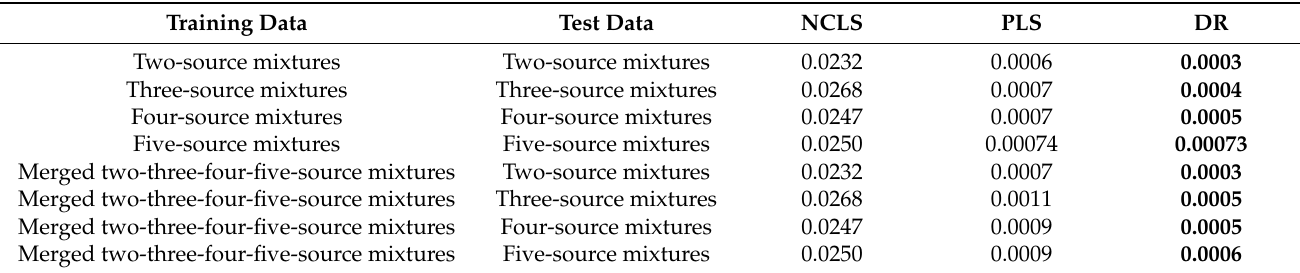
Table 7. Average RMSE results when foreground spectra are used for mixing-rate estimation in the “low-mixing-rate mixture” dataset (Mixing-rate range used for synthesizing mixtures is: [10 − 3 10 − 1 ], Min: 10 − 3 , Max: 10 − 1 ). Bold numbers indicate best performing